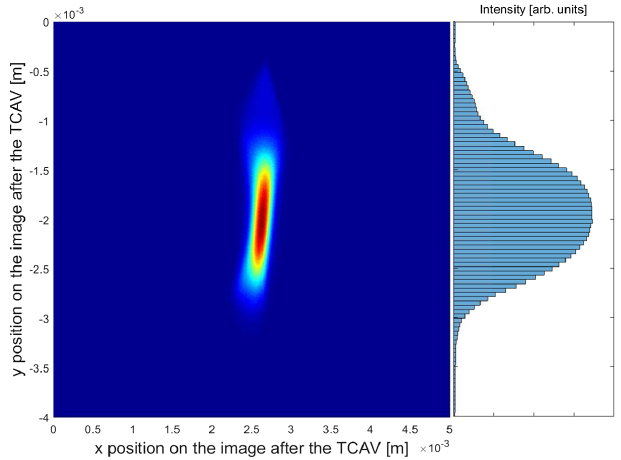
10. Screen-5 image taken with transverse deflecting cavity on, and the corresponding intensity distribution F ð y Þ along the vertical